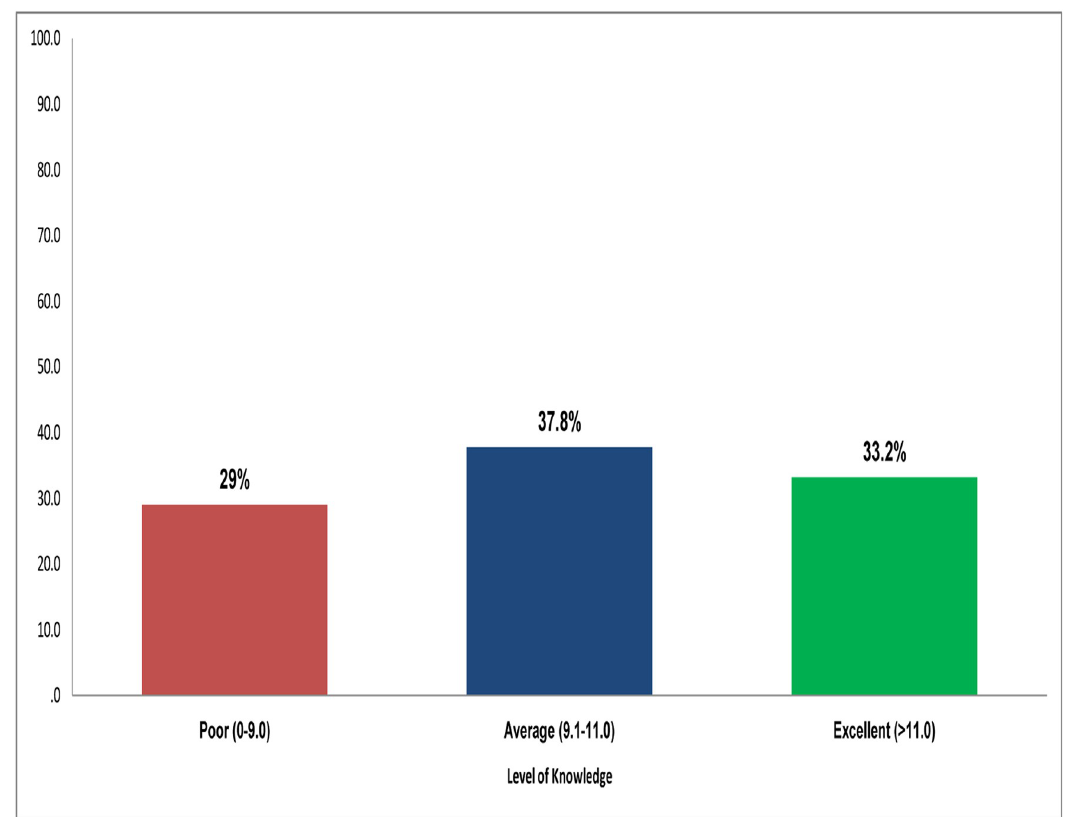
Fig 1. Levels of knowledge regarding palliative care (n =